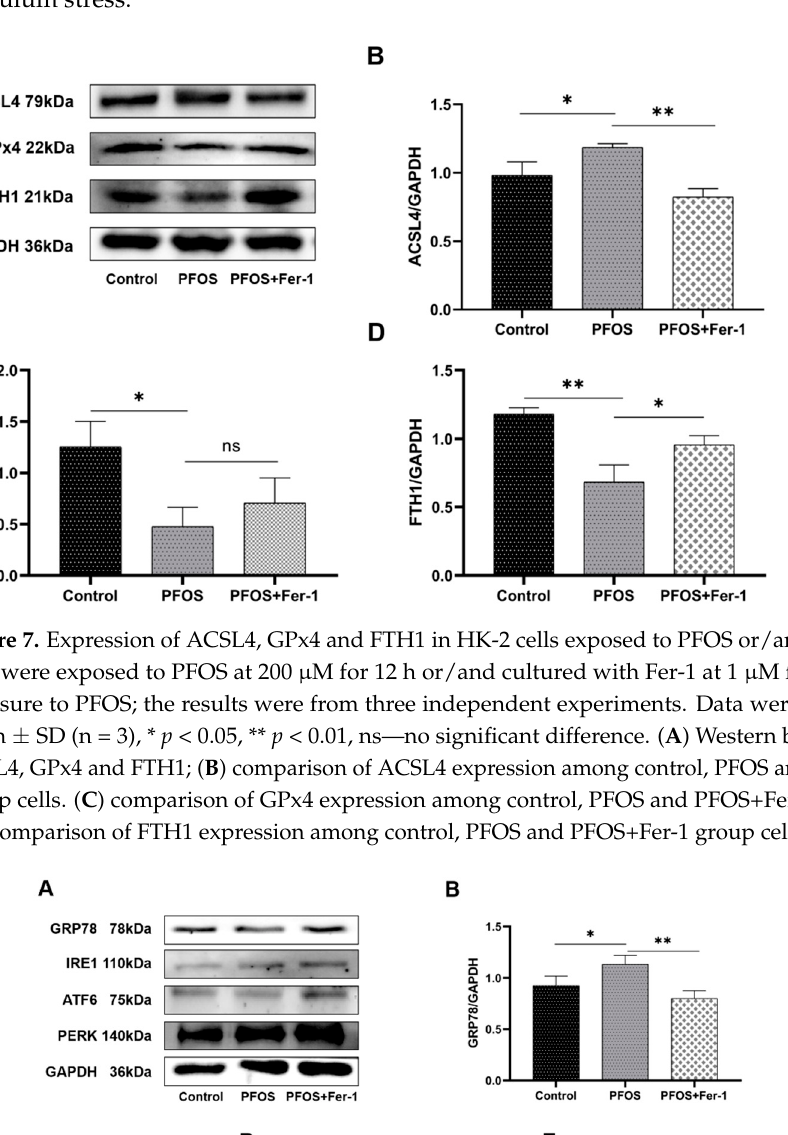
Figure 8. Expression of GRP78, IRE1, ATF6 and PERK in HK ‐ 2 cells exposed to PFOS or/and Fer ‐ 1.